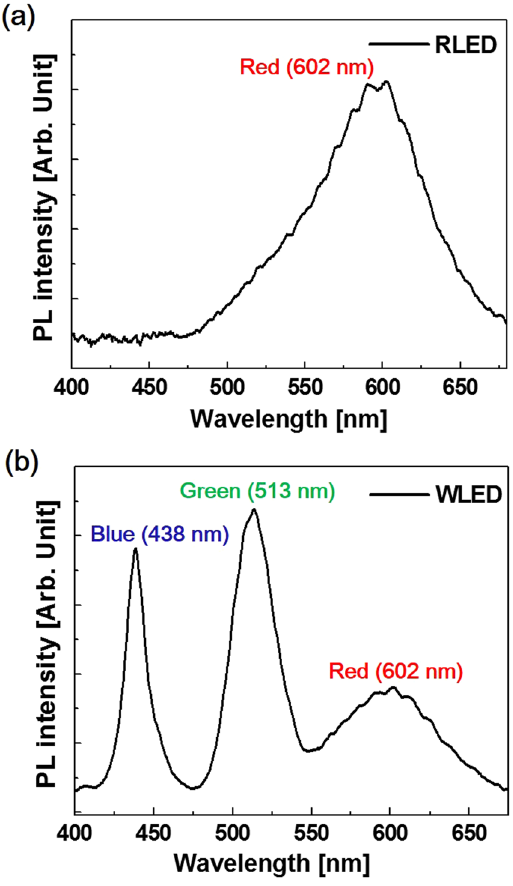
Figure 3. PL spectra of ( a ) the RLED and ( b ) WLED measured at